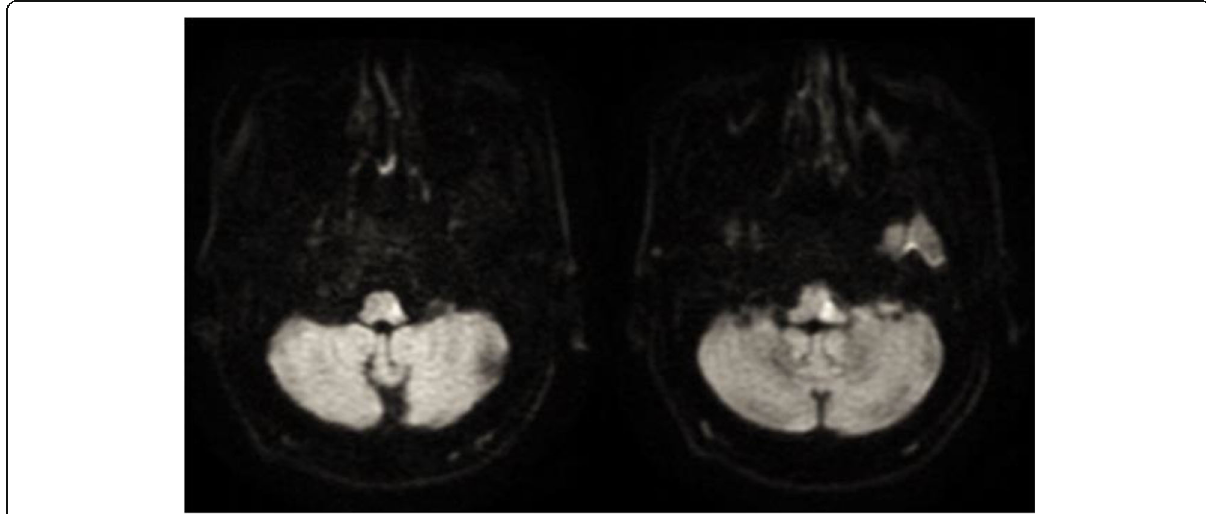
Fig. 1 Left lateral medullary infarction along axial magnetic resonance imaging